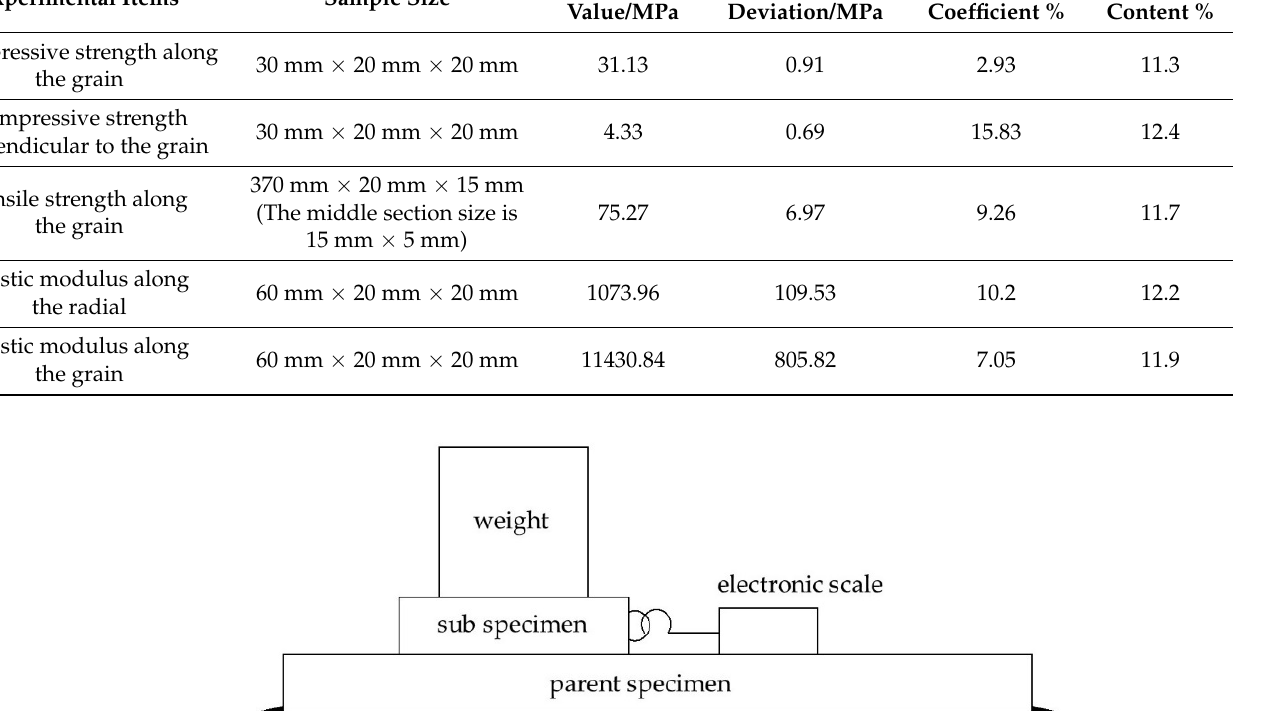
( d ) Figure 14. Experimental phenomena and failure modes of specimen BS1: ( a ) slight extrusion deformation; ( b ) cracking at the bottom of the tenon neck; ( c ) cracking at the top of the tenon neck; ( d ) tensile damage. For specimens BS2–BS3, the test phenomenon at the beginning and middle stage of loading was similar to that of specimen BS1, but the final failure mode of each specimen is different. Transverse cracks were generated at the upper end of the beam tenon of